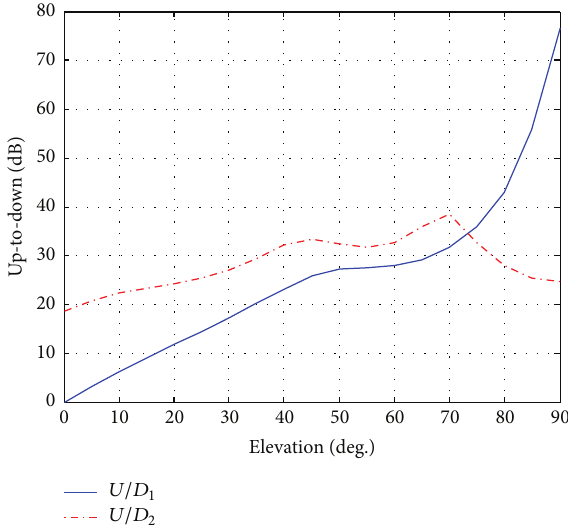
Figure 4: The 𝑈/𝐷 ratios in dB for choke